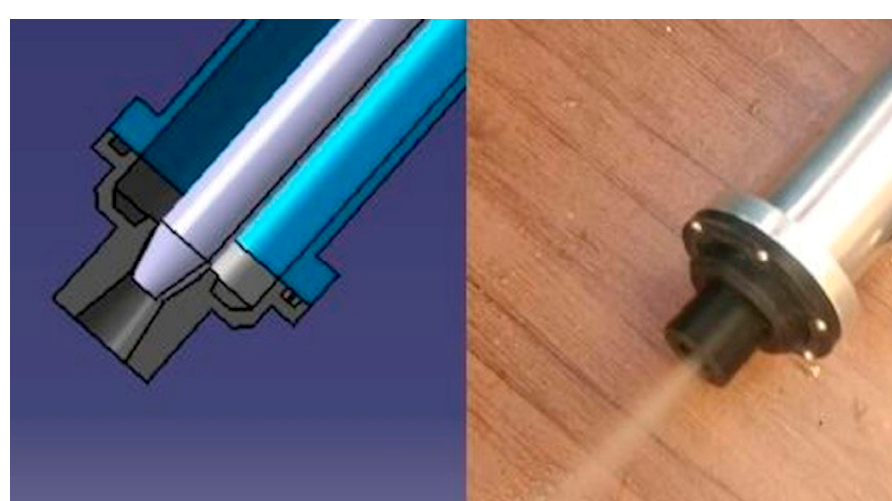
Figure 6. CAD design and the assembled valve.